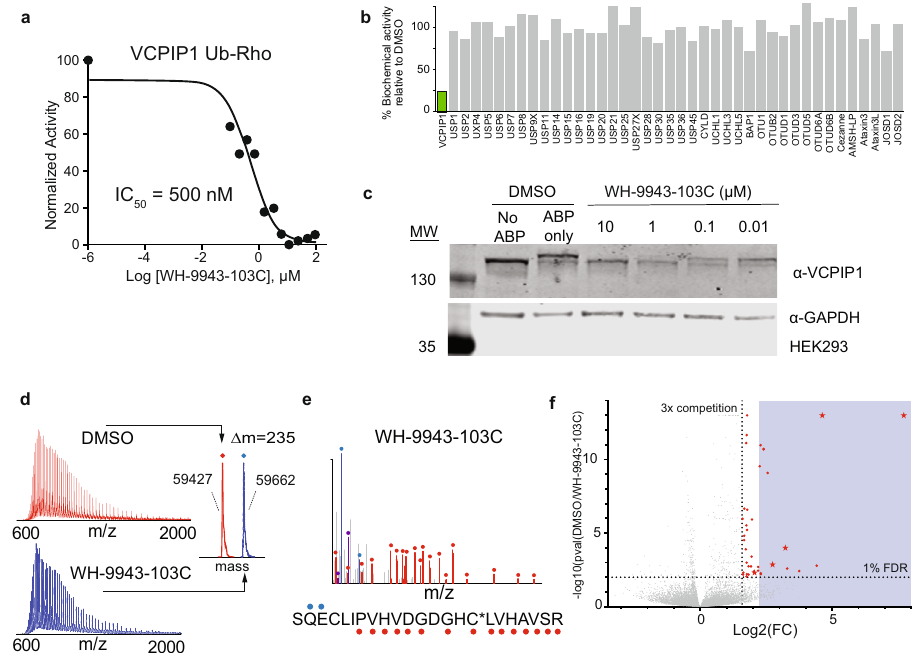
Fig. 5 | VCPIP1 hit validation. a Hit molecule WH-9943-103C inhibited deubiqui- tination activity of VCPIP1 in Ub-Rho cleavage assay after 6 h incubation ( n = 1). b WH-9943-103C inhibited VCPIP1 (highlighted in green) selectively out of a panel of 41 puri fi ed recombinant DUBs after 15 min incubation. c WH-9943-103C dis- played in-cell target engagement as determined for DUB labeling by ABP then visualized on a Western blot. d WH-9943-103C labeled recombinant VCPIP1 with 1:1 stoichiometry as read out by intact protein mass spectrometry. Labeled ion envelope is shown in blue, unlabeled ion envelopefrom DMSO control is shown in red. e CE-MS/MS identi fi ed the catalytic cysteine of VCPIP1 to be covalently mod- i fi ed by WH-9943-103C, red and blue glyphs adjacent to the peptide sequence